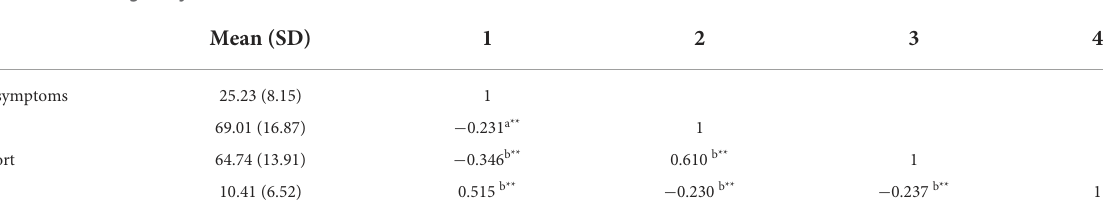
TABLE 2 Correlations among study variables.